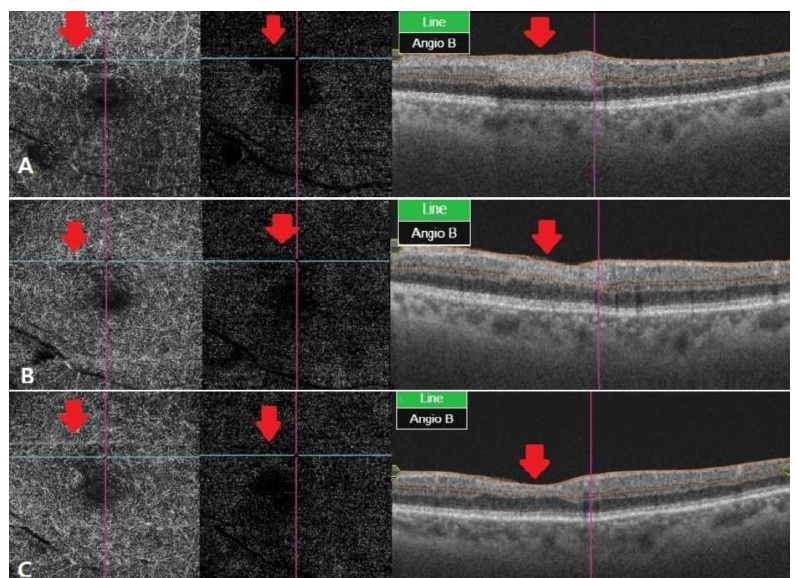
Figure 3. OCT angiography at different stages of RAO. ( A ) After two weeks, OCT angiography was observed with vessel damage and window defect in deep and outer retina. ( B ) After a month, OCT angiography showed recovered vascular damage of deep and outer retina. This seems to be due to reperfusion and reduced window defect. ( C ) Two months later, deep and outer retinafully recovered in vascular findings. The macular window defect in the choriocapillaris area seems to be due to underlying drusen and PED.